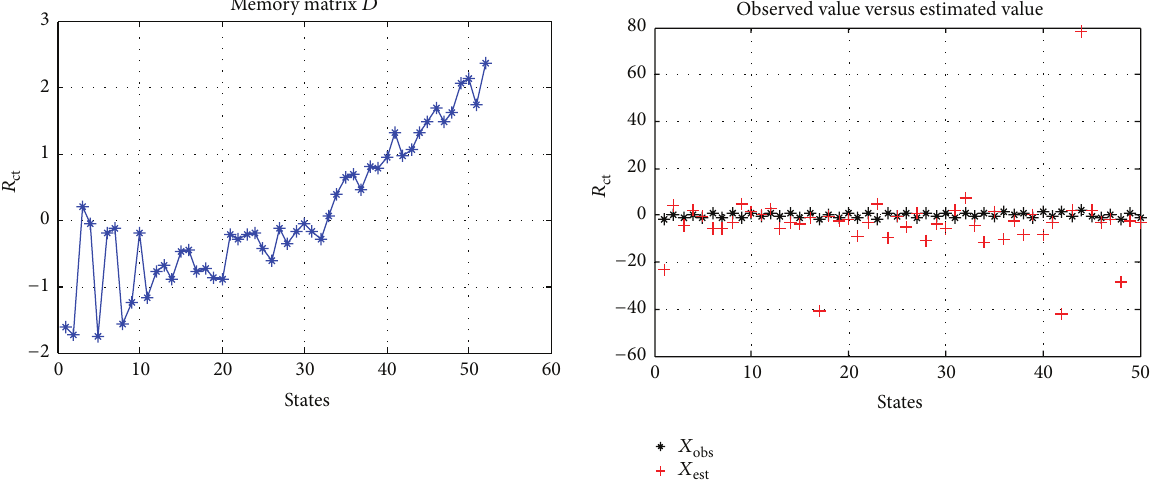
Figure 7: Memory matrix 𝐷 with strong correlation.